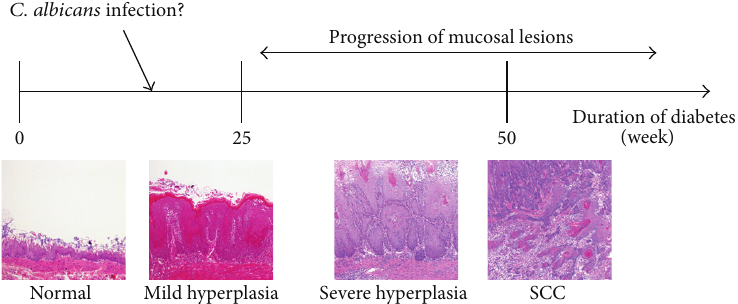
Figure 1: Schematic depicting the approximate time course of forestomach lesion development.